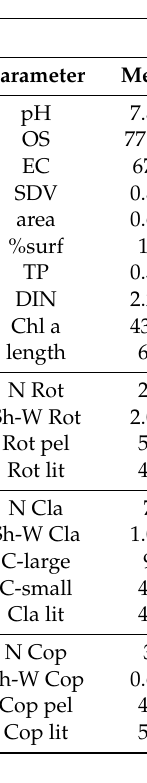
Table 1. Descriptive statistics of zooplankton community indices and results of Mann–Whitney (M–W) test in two types of water bodies (Rot—rotifers, Cla—cladocerans, Cop—copepods; pel—% participation of pelagic species; lit—% participation of littoral species; N—number of species; C-large—abundance (ind L − 1 ) of large cladocerans; C-small—abundance (ind L − 1 ) of small cladocerans; Sh-W—Shannon Weaver index value) and environmental parameters of the studied small water bodies (length—macrophyte length; pH—water reactivity; TP—total phosphorus; DIN—dissolved inorganic nitrogen; Chl a—chlorophyll a concentration; OS—oxygen saturation; EC—conductivity; SDV—Secchi disc visibility; %surf—% overshading of the water surface caused by coverage of nymphaeids and pleustophytes; LowHI—low human alteration; HighHI—high human alteration; Min—Minimum;